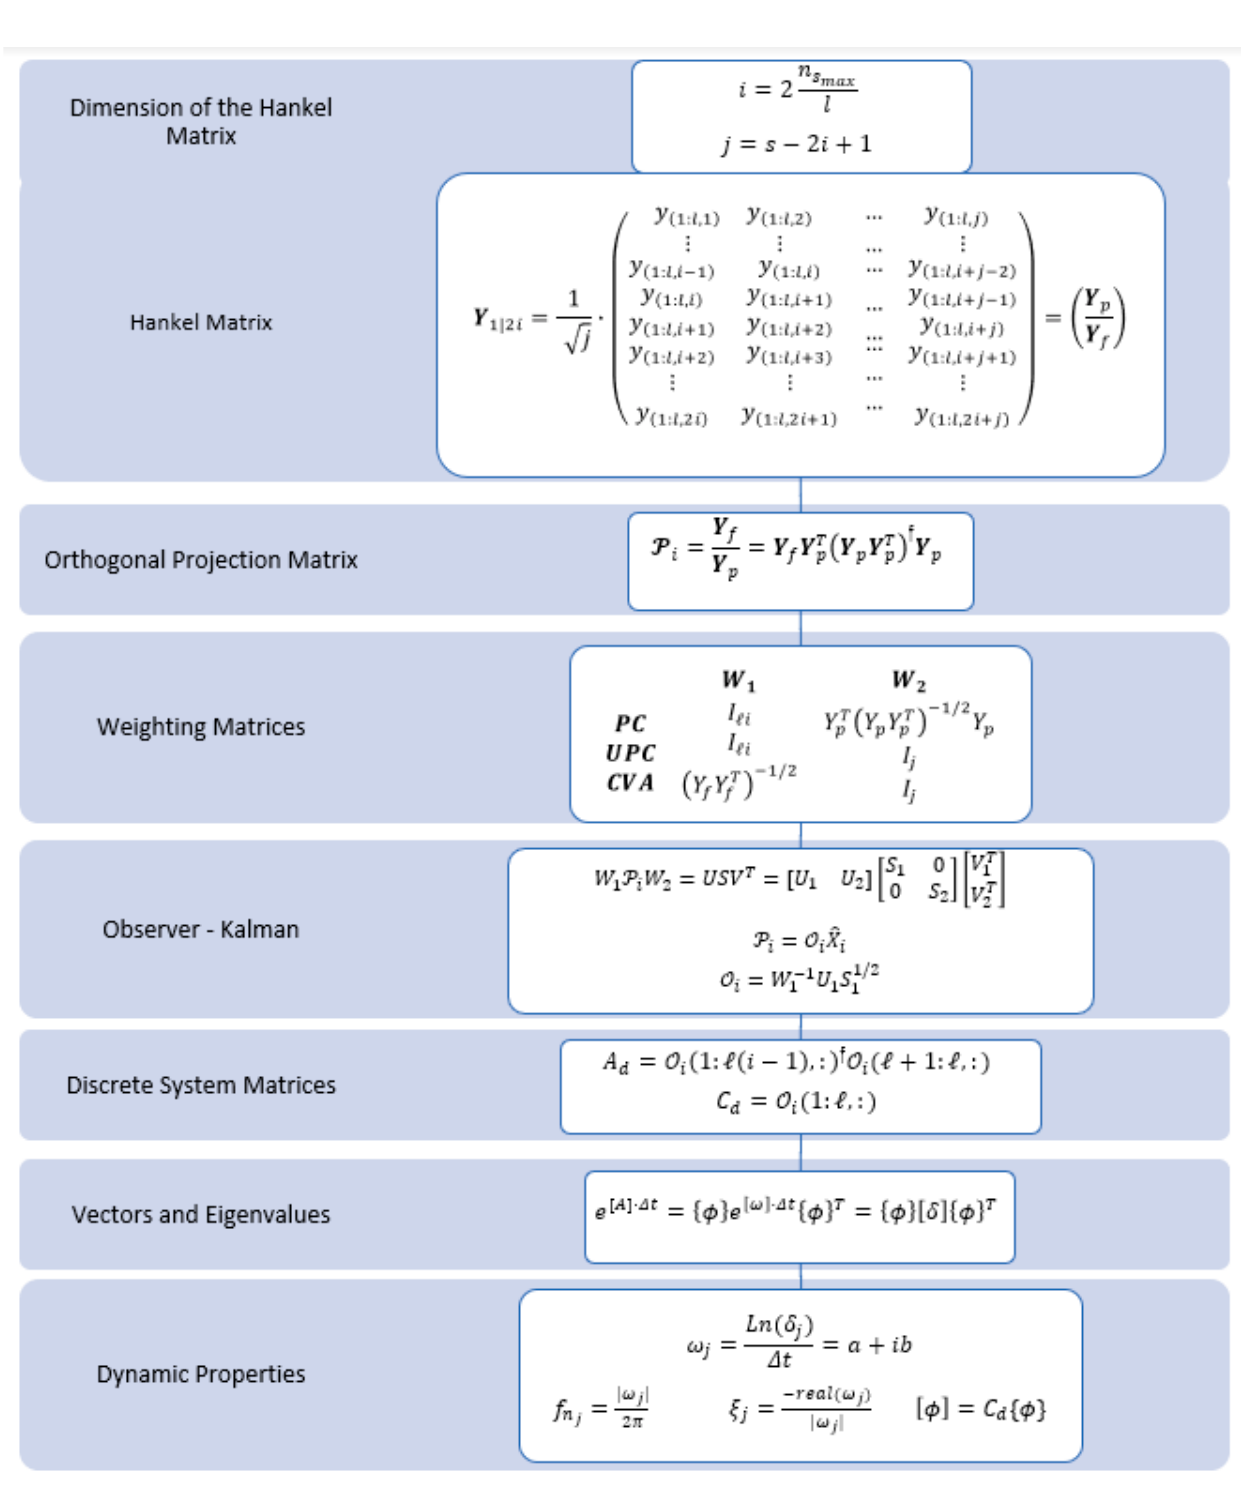
Figure 5. Flow diagram of the SSI method.